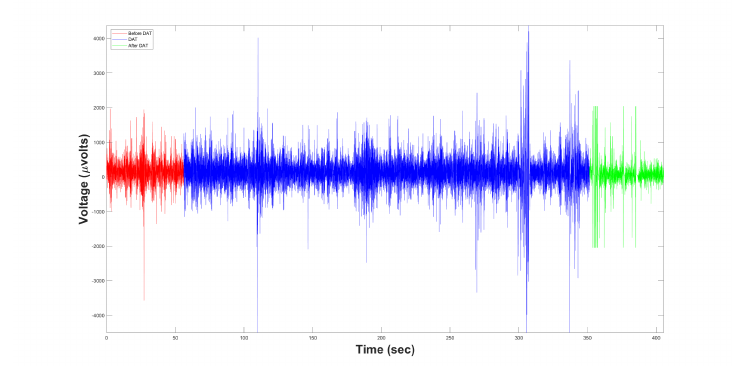
Figure 9. Representation of the RAW data in µ V.